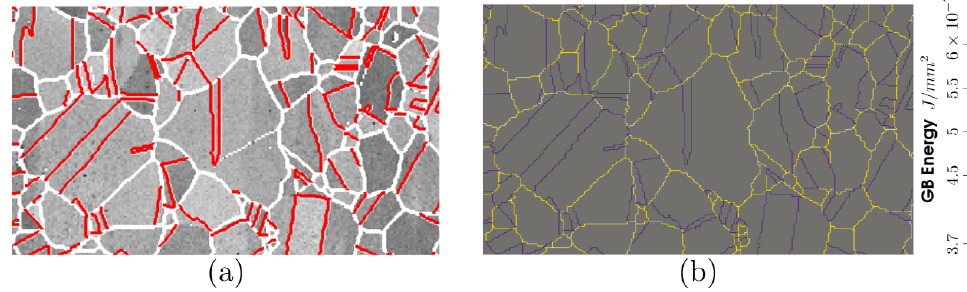
Figure 19. Detail of the ( a ) EBSD band contrast map and ( b ) its numerical twin showing the GB energy field. Twin boundaries depicted in red on the left image have low energy on the right